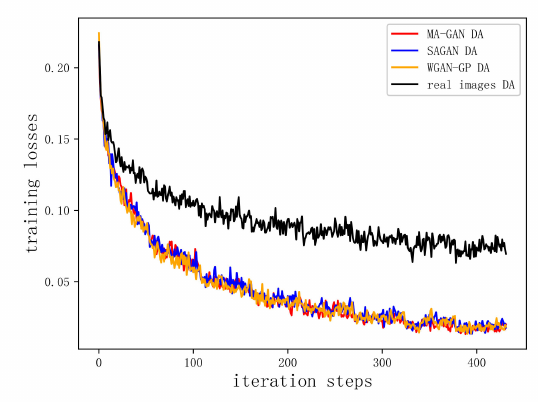
Figure 13. The change of the training loss after CIFAR-10